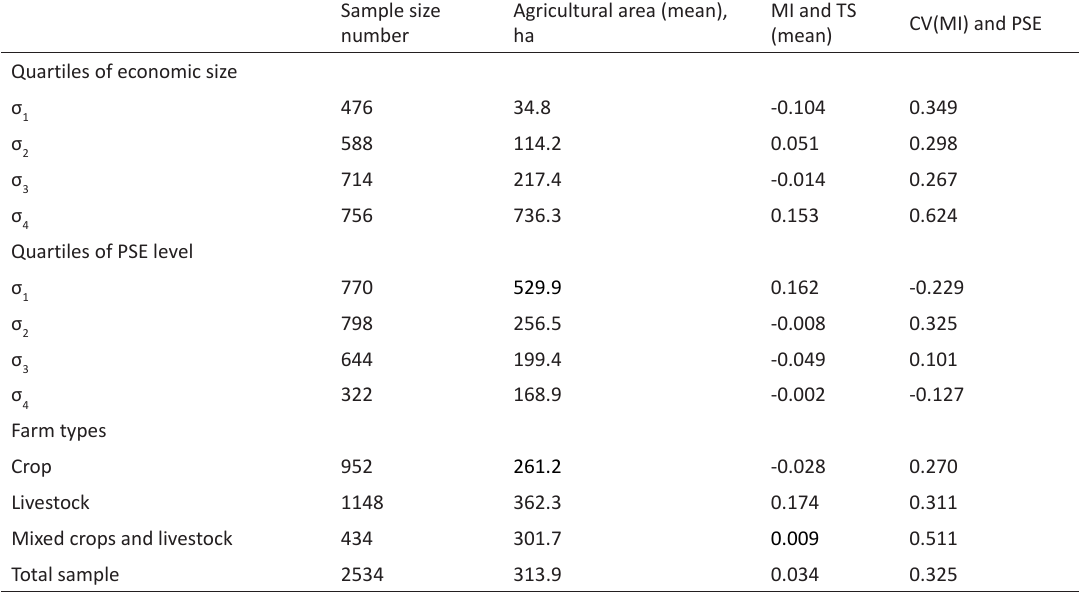
Table 5. The results of Pearson’s correlation between MI and TS, and between CV(MI) and PSE (restricted sample without observations with negative MI) Sample size